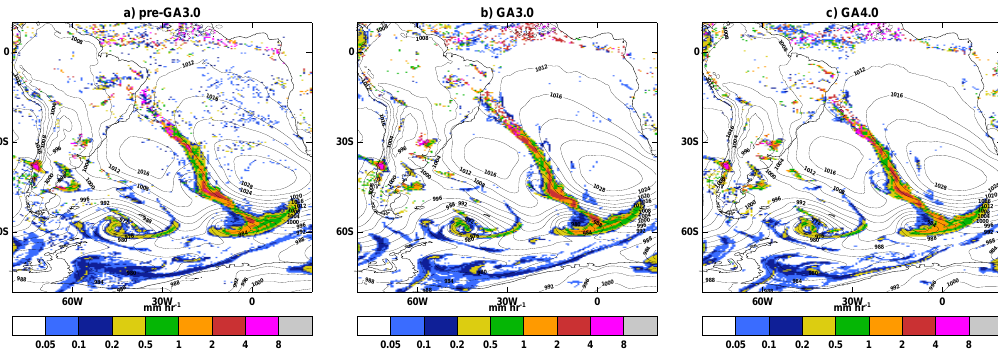
Fig. 10. A sample 24h forecast of pressure at mean sea level (contours) and instantaneous total precipitation rate from N320-AL_NWP forecasts using a pre-GA3.0 atmospheric physics package (left), GA3.0 (centre) and GA4.0 (right).